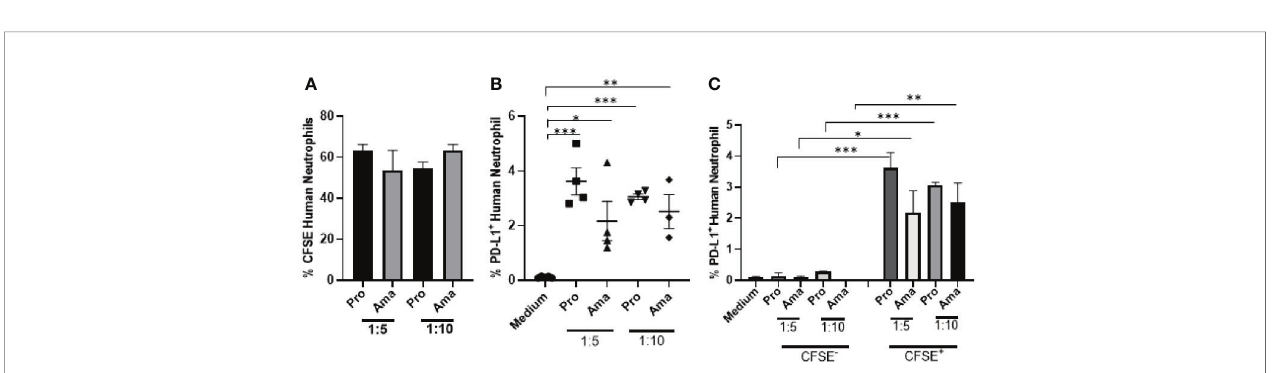
FIGURE 7 | Increased expression of PD-L1 in human neutrophils exposed to L. braziliensis . Human neutrophils (5x10 5 ) from healthy donors were incubated with CFSE- stained promastigotes (Pro) and amastigotes (Ama) of L. braziliensis (1:5 and 1:10), for 4 h. Control performed with neutrophils on medium. Cells were then analyzed by fl ow cytometry. (A) Percentage of neutrophils infected with CFSE-labeled parasites. (B) Percentage of PD-L1 + neutrophils upon interaction with parasites. (C) Percentage of PD-L1 expression on CFSE - (bystander) and CFSE + neutrophils. Data are mean ± SEM (N=4-5). *p < 0.0303, **p < 0.0047 ***p <